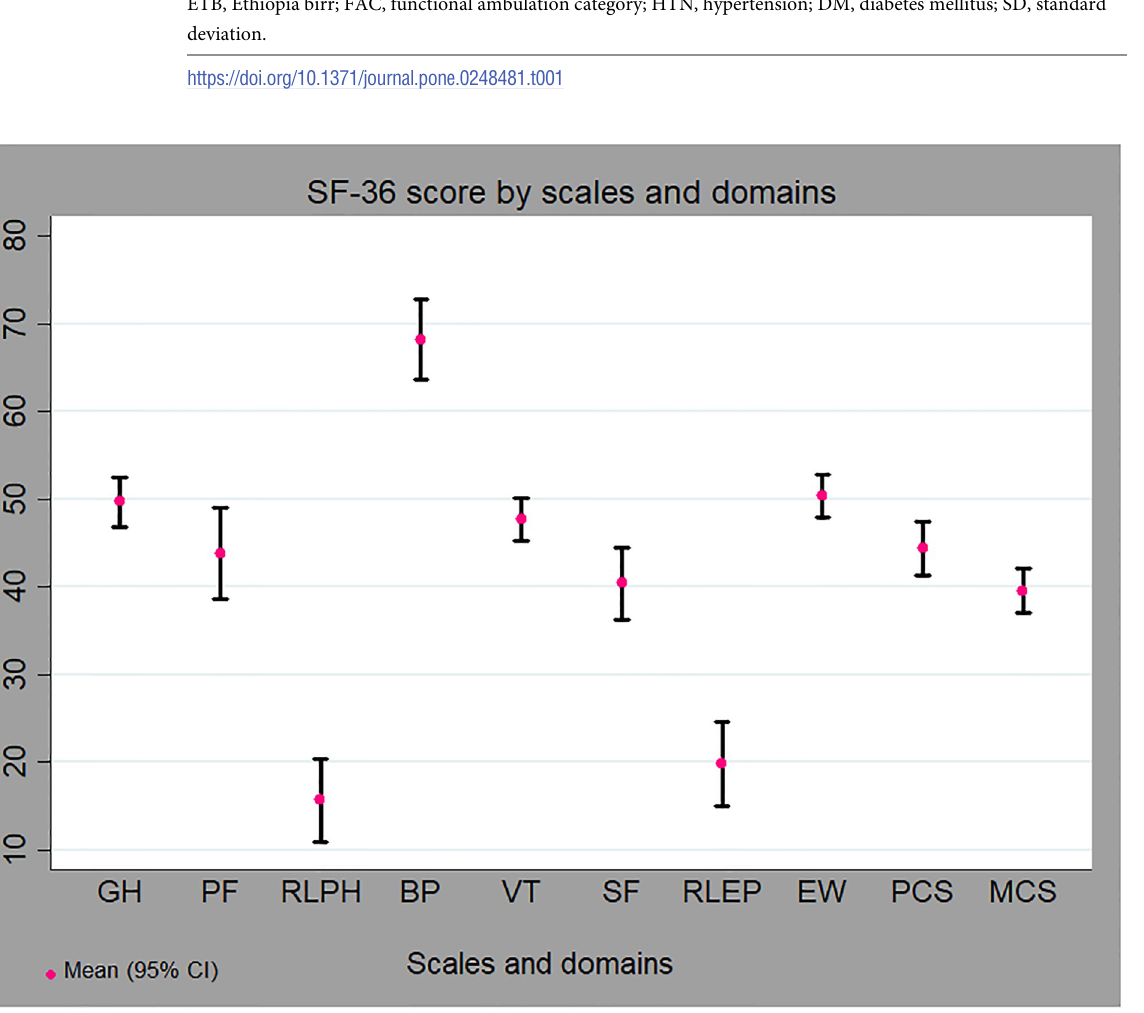
Fig 1. HRQOL scales and domains score of patients with stroke. SF-36 scales: GH, General health perceptions; PF, Physical functioning; RLPH, Role limitations due to physical health problems; BP, Bodily pain; VT, Fatigue; SF, Social functioning; RLEP, Role limitations due to emotional problems; EW, Emotional wellbeing. SF-36 domains: PCS, Physical component score; MCS, Mental component score.